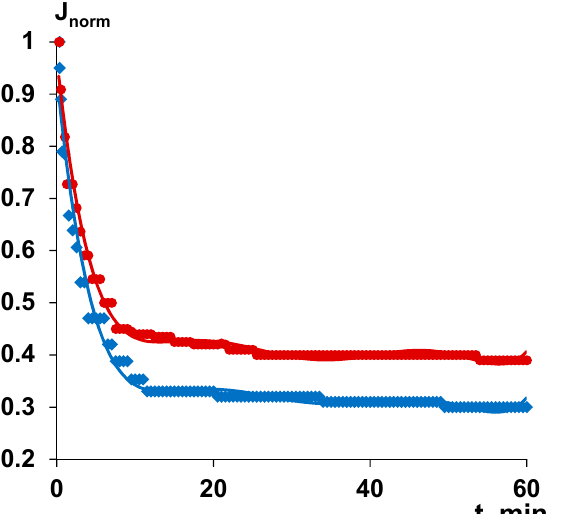
Figure 13. The dependence of normalized flux (J/J 0 ) of surface water during ultrafiltration of reference (1—A60) and modified (2—A-0.3-60) membranes. Table 5. Characteristics of feed surface water and permeate.